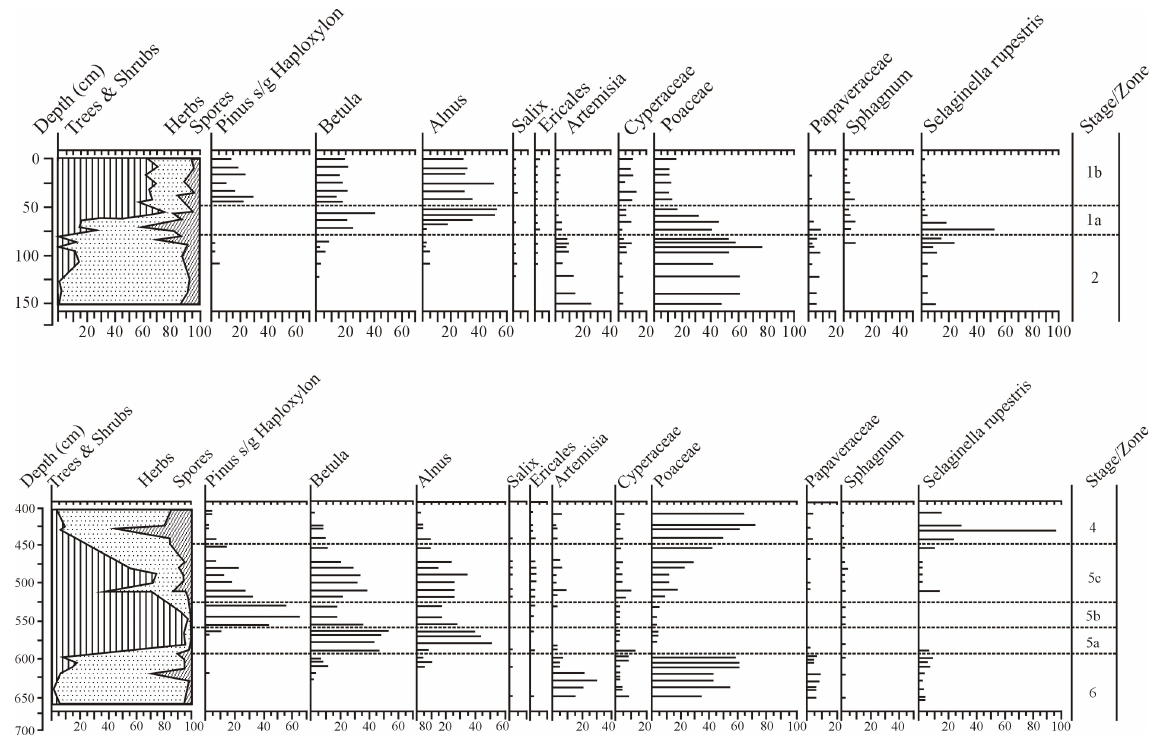
Fig. 2. Percentage diagram of select taxa from MIS1 and MIS2 and MIS4 to MIS6. Results are from core PG-1352. Note that labels for the pollen assemblages include both a number, indicating the isotope stage, and a letter, indicative of the pollen zone. Climatic optima are represented by zones 1a and